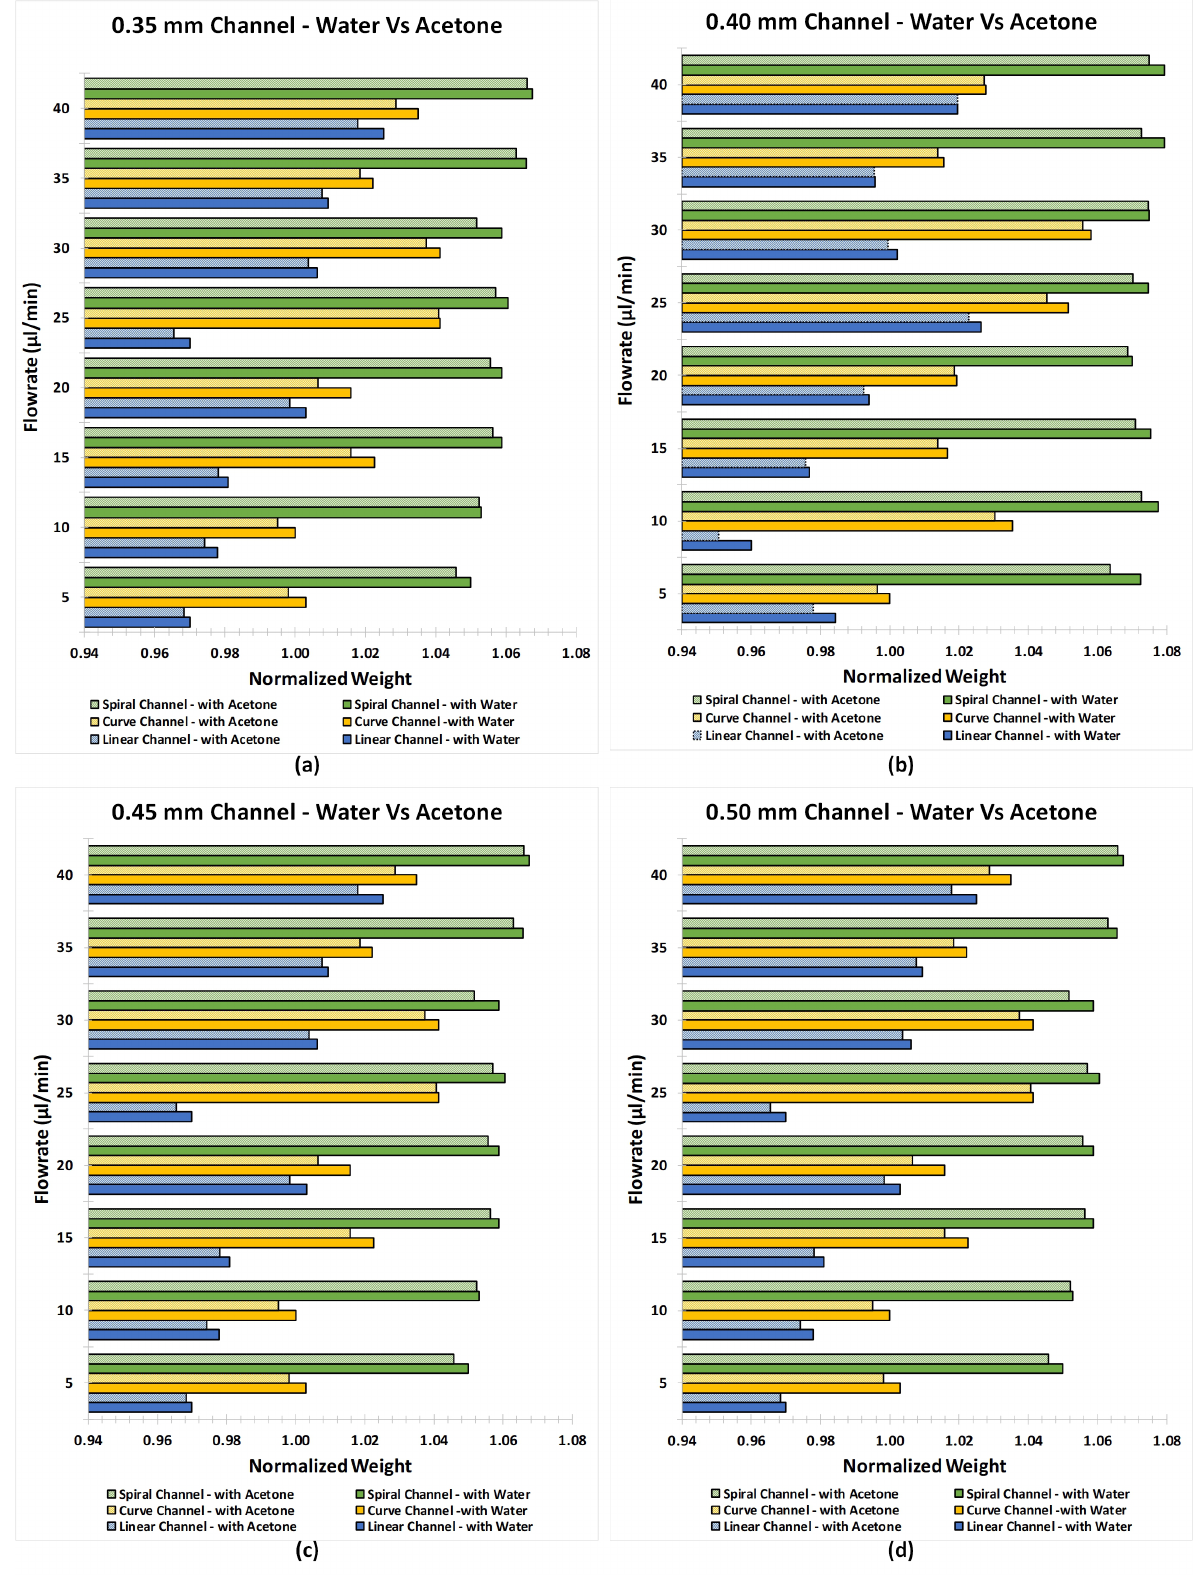
Figure 12. Post-treatment normalized weight analysis of linear, curved and spiral microchannel with diameter sizes of ( a ) 0.35 mm, ( b ) 0.4 mm, ( c ) 0.45 mm, and ( d ) 0.5